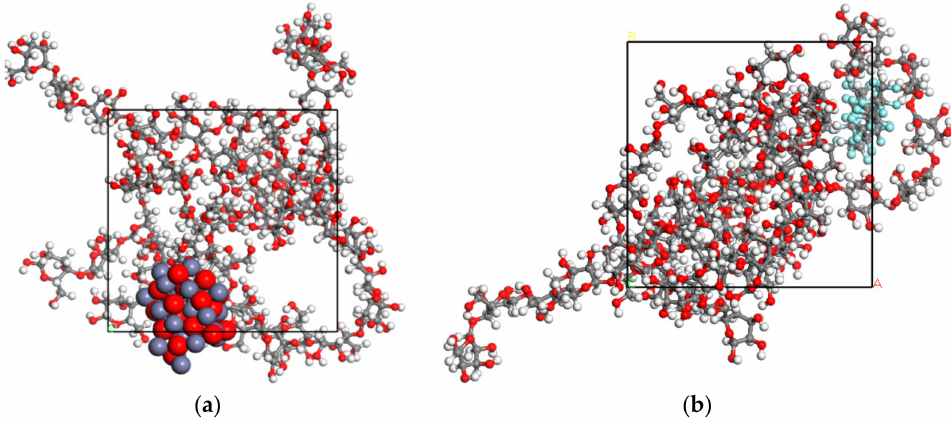
Figure 1. The initial models of ( a ) a ZnO nanoparticle and cellulose, and ( b ) a PTFE nanoparticle and